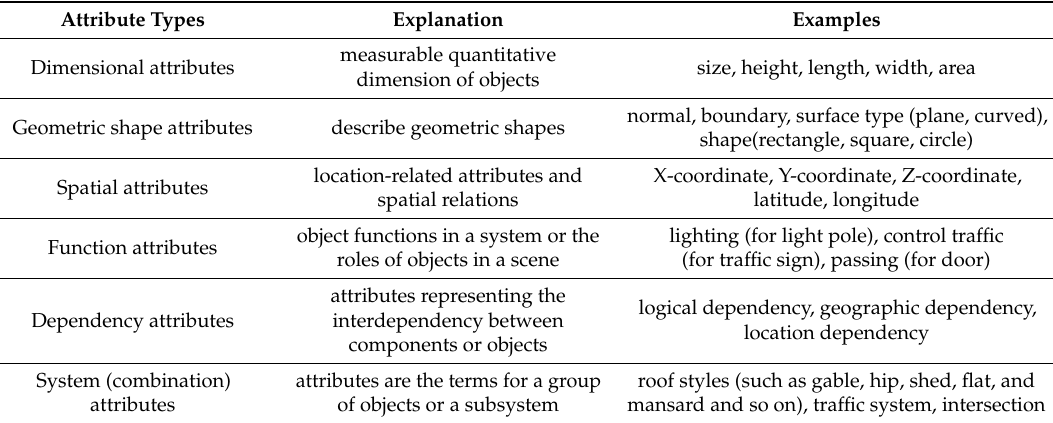
Table 3. Classification of attributes in the